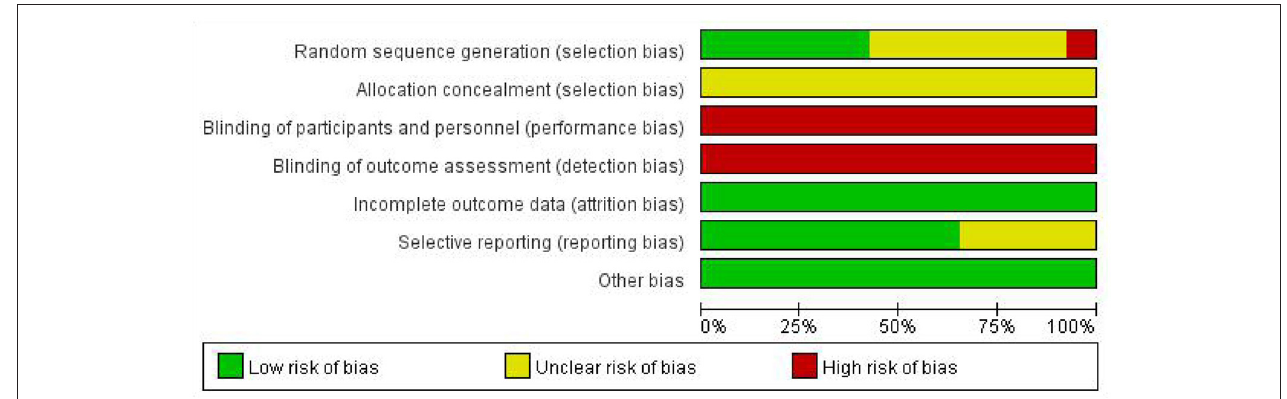
FIGURE 2 | Risk of bias